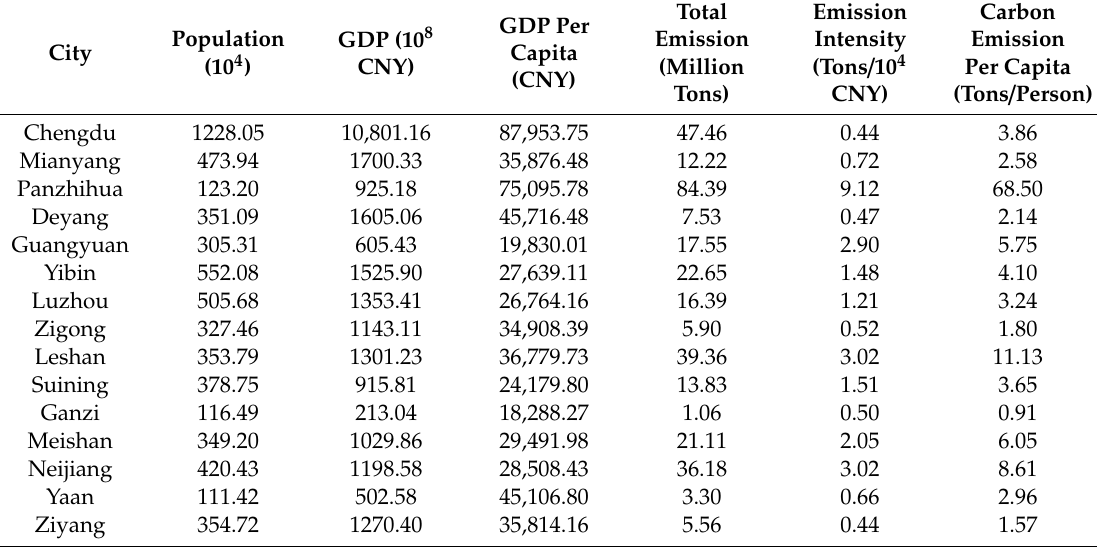
Table 1. Emission and socio-economic indicators of 15 cities in Sichuan Province,